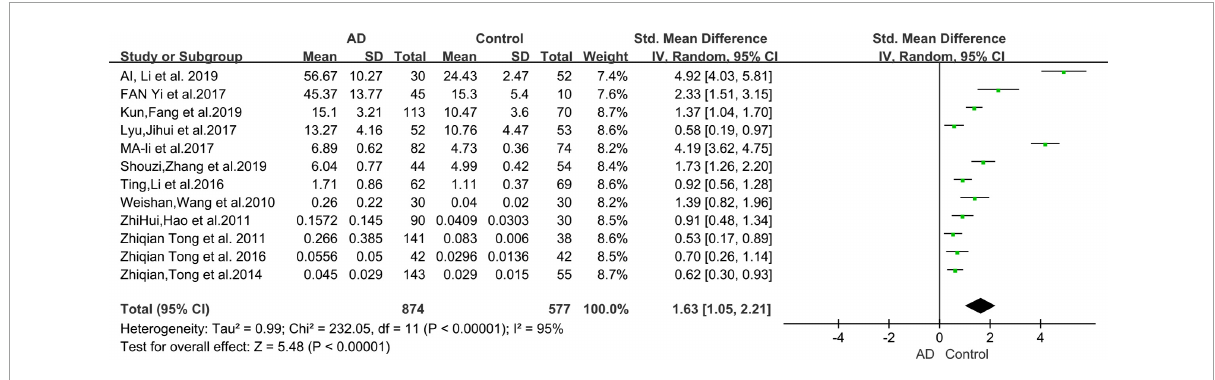
FIGURE2 Forest plot of a random effects meta-analysis of urine FA levels in AD patients and HCs. Diamonds represent combined effect estimates. The size of the green box is proportional to the weight assigned to each study, with horizontal lines representing 95% confidence interval (CI). AD, Alzheimer’s disease; FA, formaldehyde; SD, standard